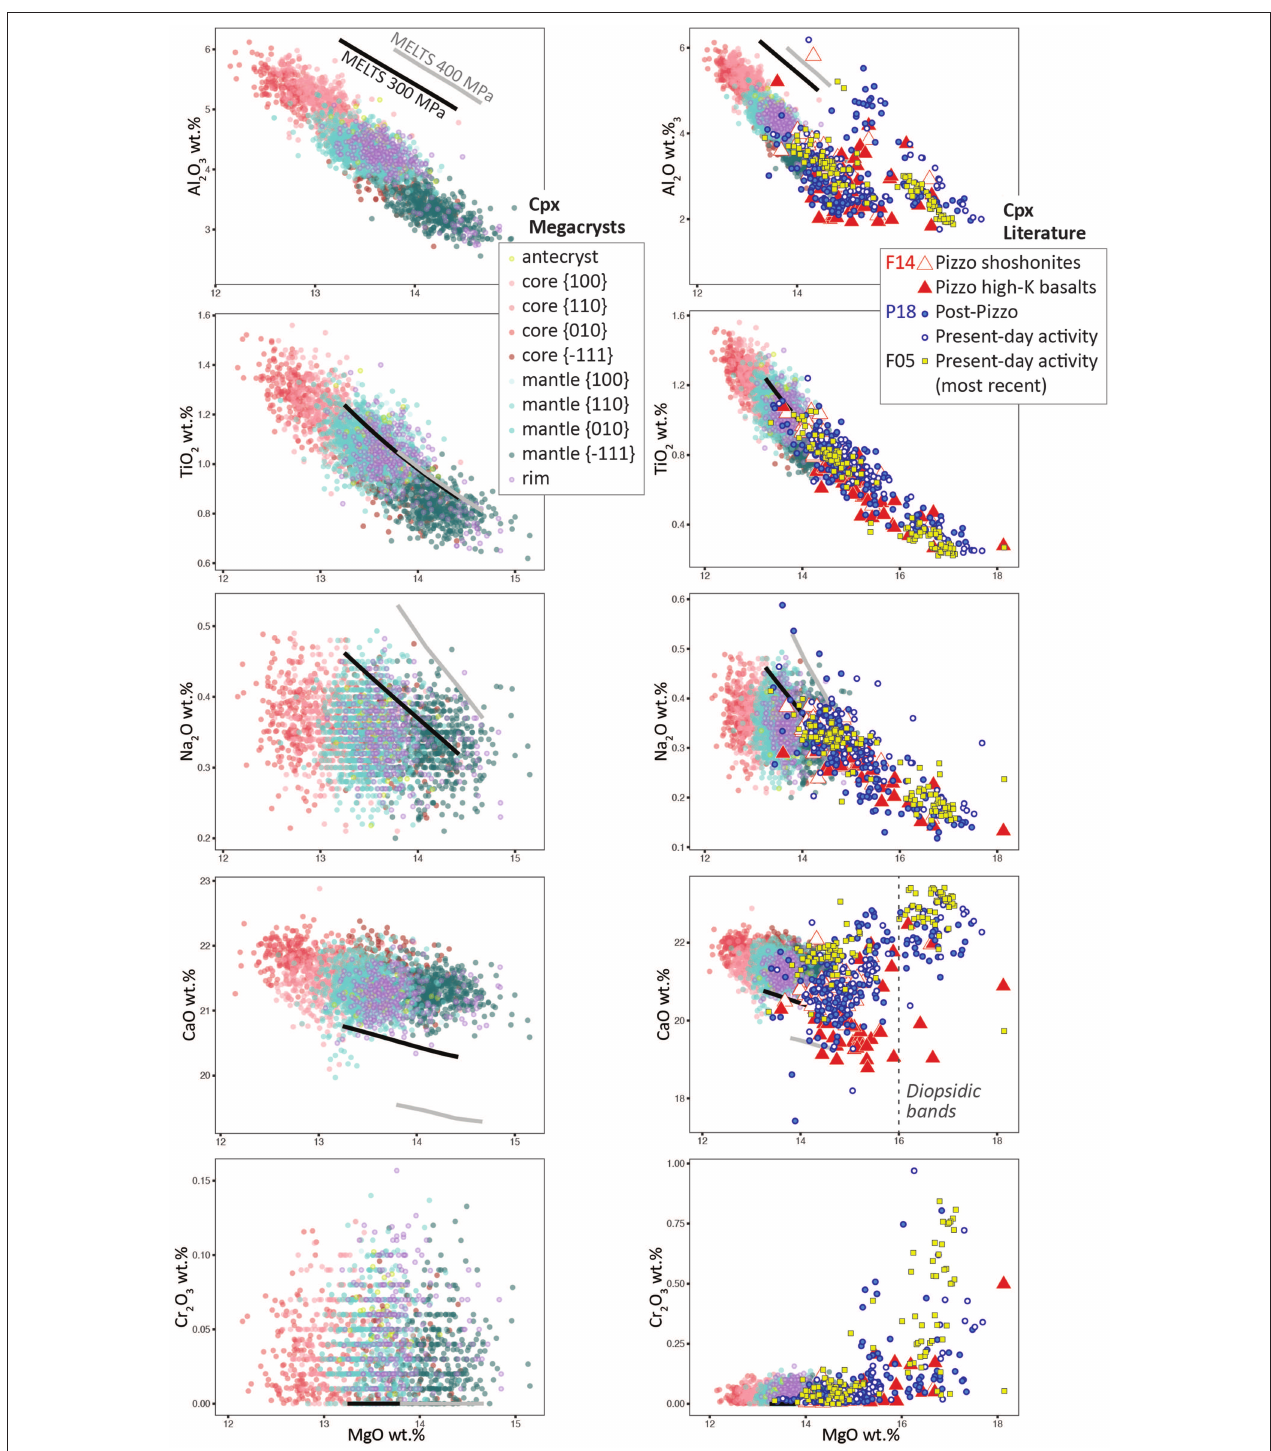
FIGURE 7 | Clinopyroxene compositional variations. (Left) Major element compositions across the clinopyroxene megacrysts, obtained by electron microprobe. The data from core, mantle and rim regions are largely coincident, however crystal cores reach highest Al 2 O 3 -Ti 2 O and lowest Si 2 O-MgO concentrations. Note the overlap among prism sectors {100}, {110}, and {010}, and the MgO-rich and Al 2 O 3 -poor composition of hourglass sectors { − 111} compared to prism sectors. The black and gray lines represent the evolution of fractionated clinopyroxene modelled with Rhyolite-MELTS (Gualda et al., 2012) from 1,090 ◦ C (high MgO) to 1,030 ◦